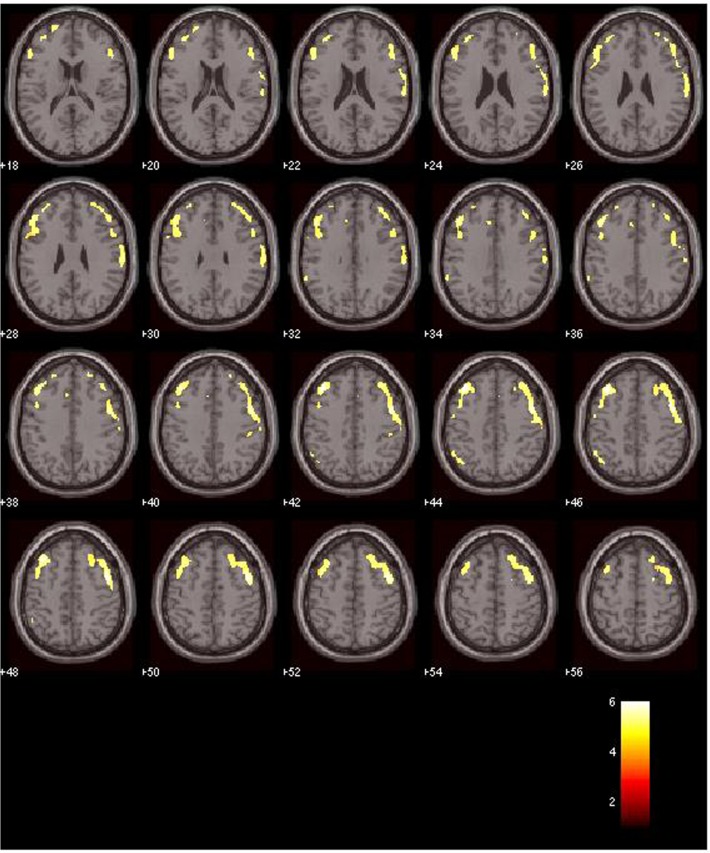
Whole-brain maps illustrate GMV differences in the SCZ/ANX group as compared to the SCZ group.For visualization purposes, the statistical maps were thresholded at P< 0.03-uncorrected. Size and location of clusters are reported in Table 2.